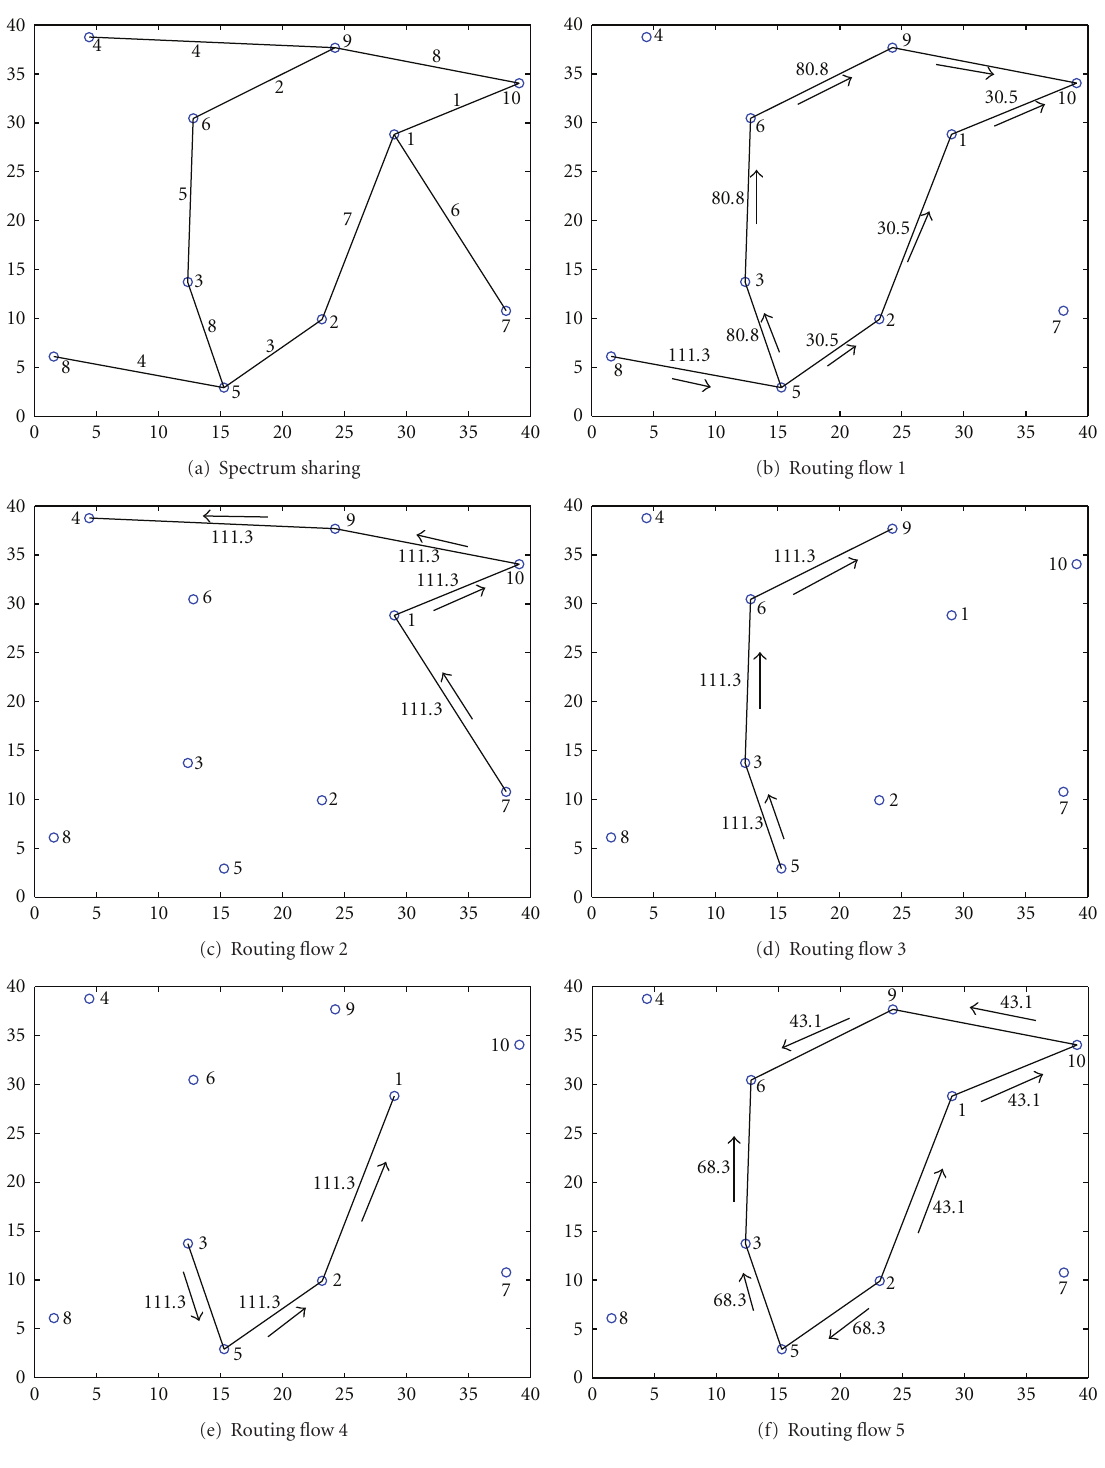
Figure 7: Spectrum sharing and routing for random